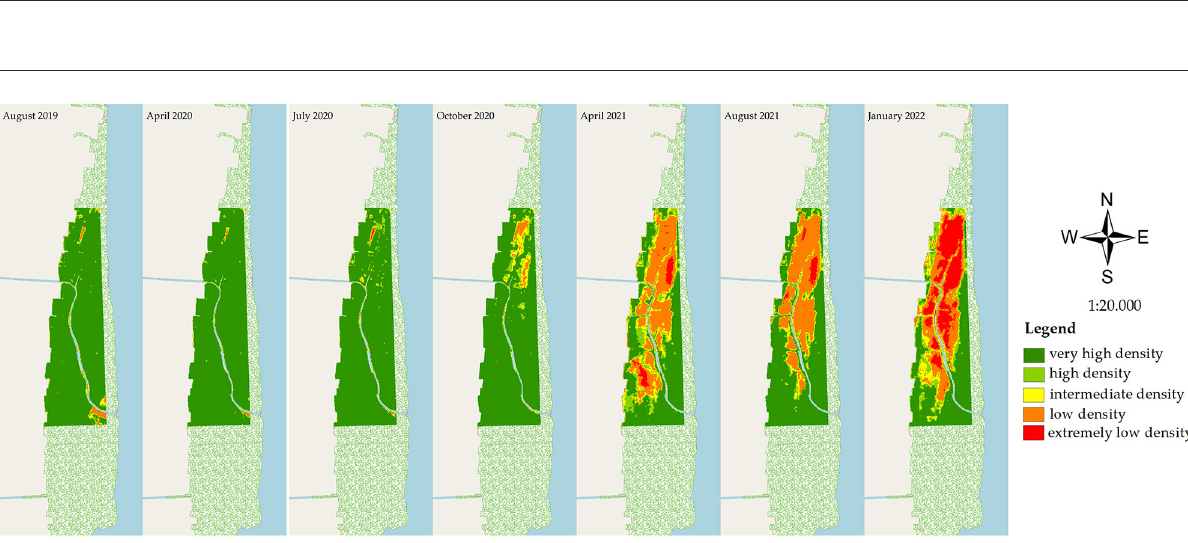
the total mangrove area in East Lampung) was affected by the dieback